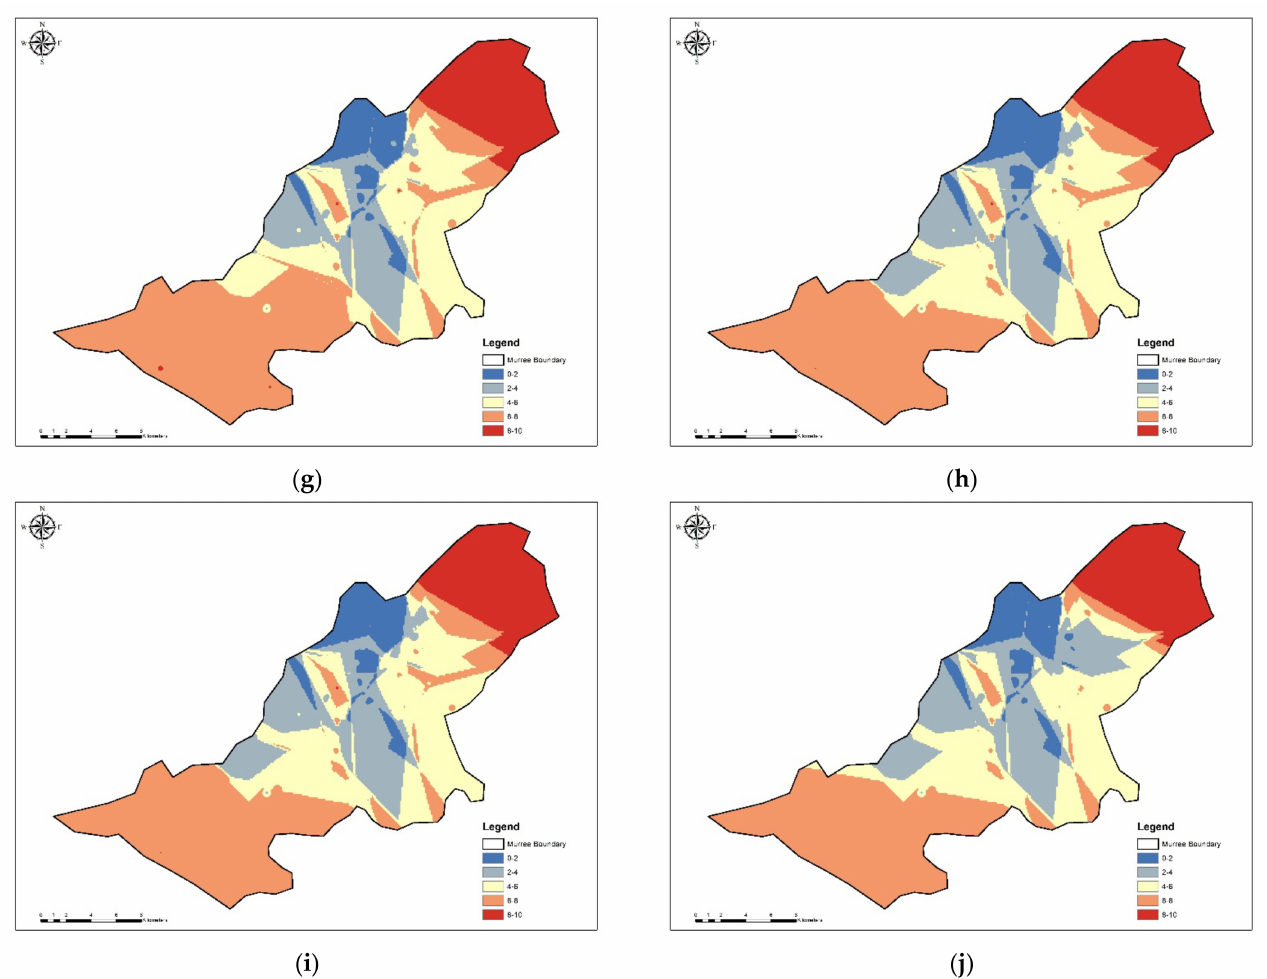
Figure 6. Plasticity maps at ( a ) 1.52 m depth, ( b ) 3.05 m depth, ( c ) 4.57 m depth, ( d ) 6.10 m depth, ( e ) 7.62 m depth and ( f ) 9.14 m depth, ( g ) 10.67 m depth, ( h ) 12.19 m depth and ( i ) 13.72 m depth, ( j ) 15.24 m